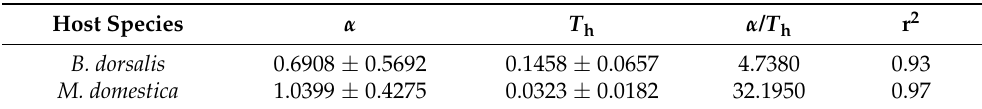
Table 2. Estimates of the functional response parameters of S. endius to pupae of B. dorsalis and M. domestica.